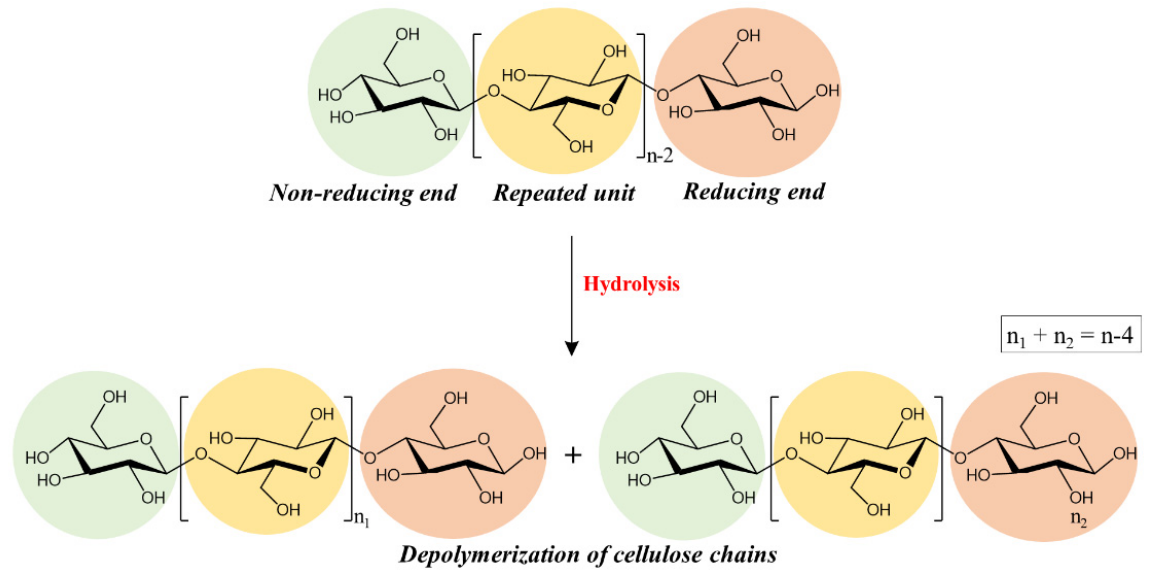
Figure 1. Hydrolysis of cellulose.